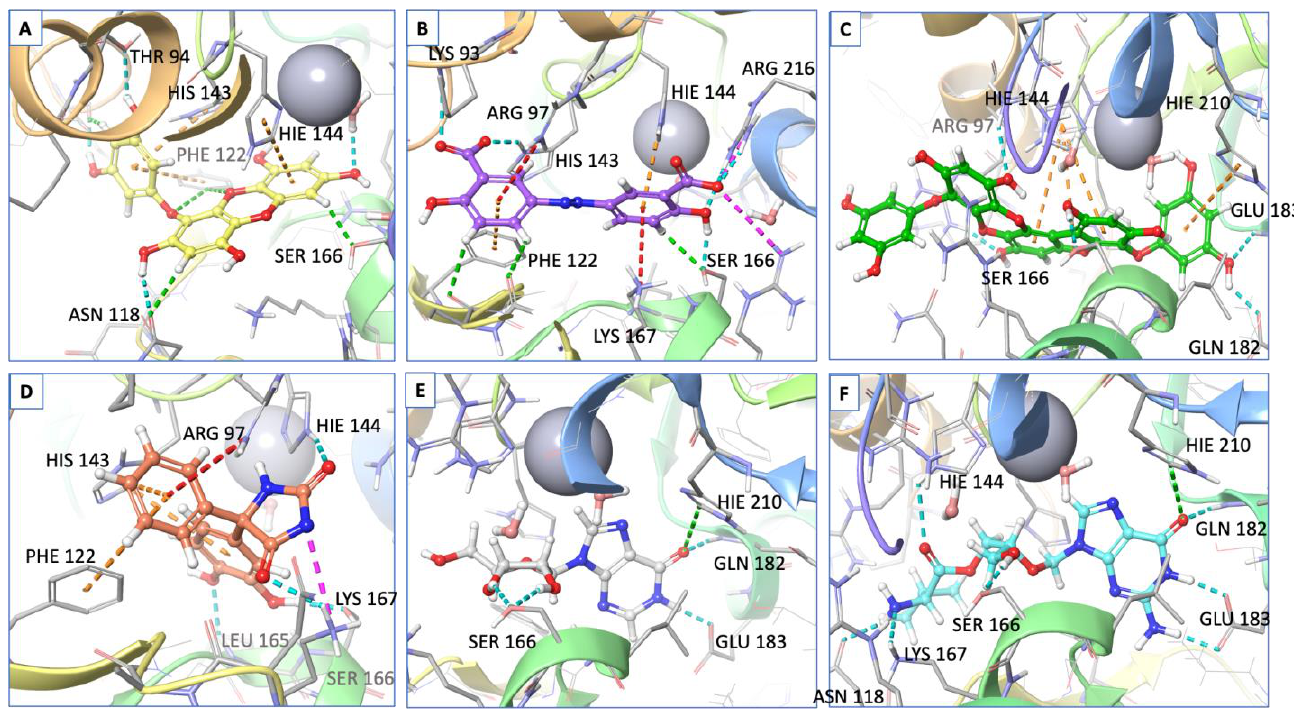
Figure 4. All six hit compounds docked in the GTPCH1-binding pocket: ( A ) Eckol, ( B ) olsalazine, ( C ) phlorofucofuroeckol, ( D ) phenytoin catechol, ( E ) inosine, ( F ) valganciclovir. All bonds are depicted as dotted lines: hydrogen bond — blue; salt bridges — pink; aromatic H-bond — green; pi – pi stacking — orange; pi-cation — red. Binding residues are annotated, and the zinc ion is depicted as a grey sphere.